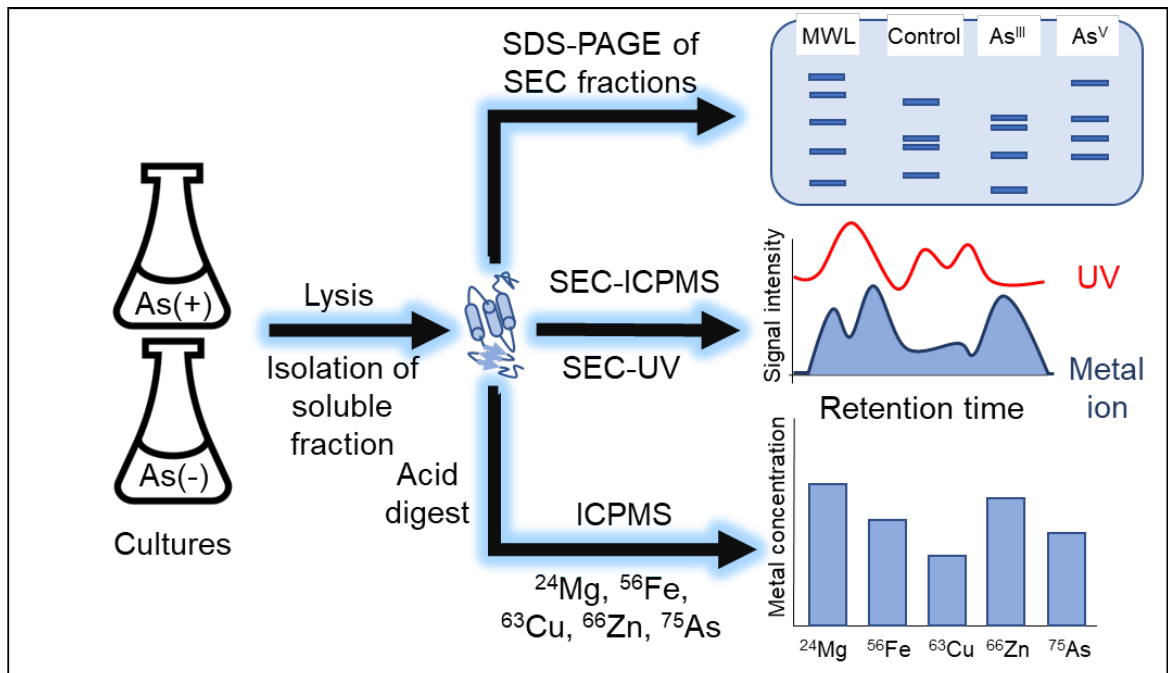
Figure 1. Metalloproteomics workflow. Replicate cultures of K12 and AW3110 +/ − As were cultured. Cells were lysed, and the soluble fraction was collected. Size-exclusion chromatography (SEC) was used for fractionating the native proteome prior to analysis by SDS-PAGE. SEC was used in-line with inductively coupled plasma mass spectrometry (SEC-ICPMS) for analysis of the native metalloproteome and in-line with a diode array detector for analysis of UV active cofactors (SEC-UV). The soluble fractions were digested with nitric acid for the analysis of cellular metal content via inductively coupled plasma mass spectrometry (ICP-MS).